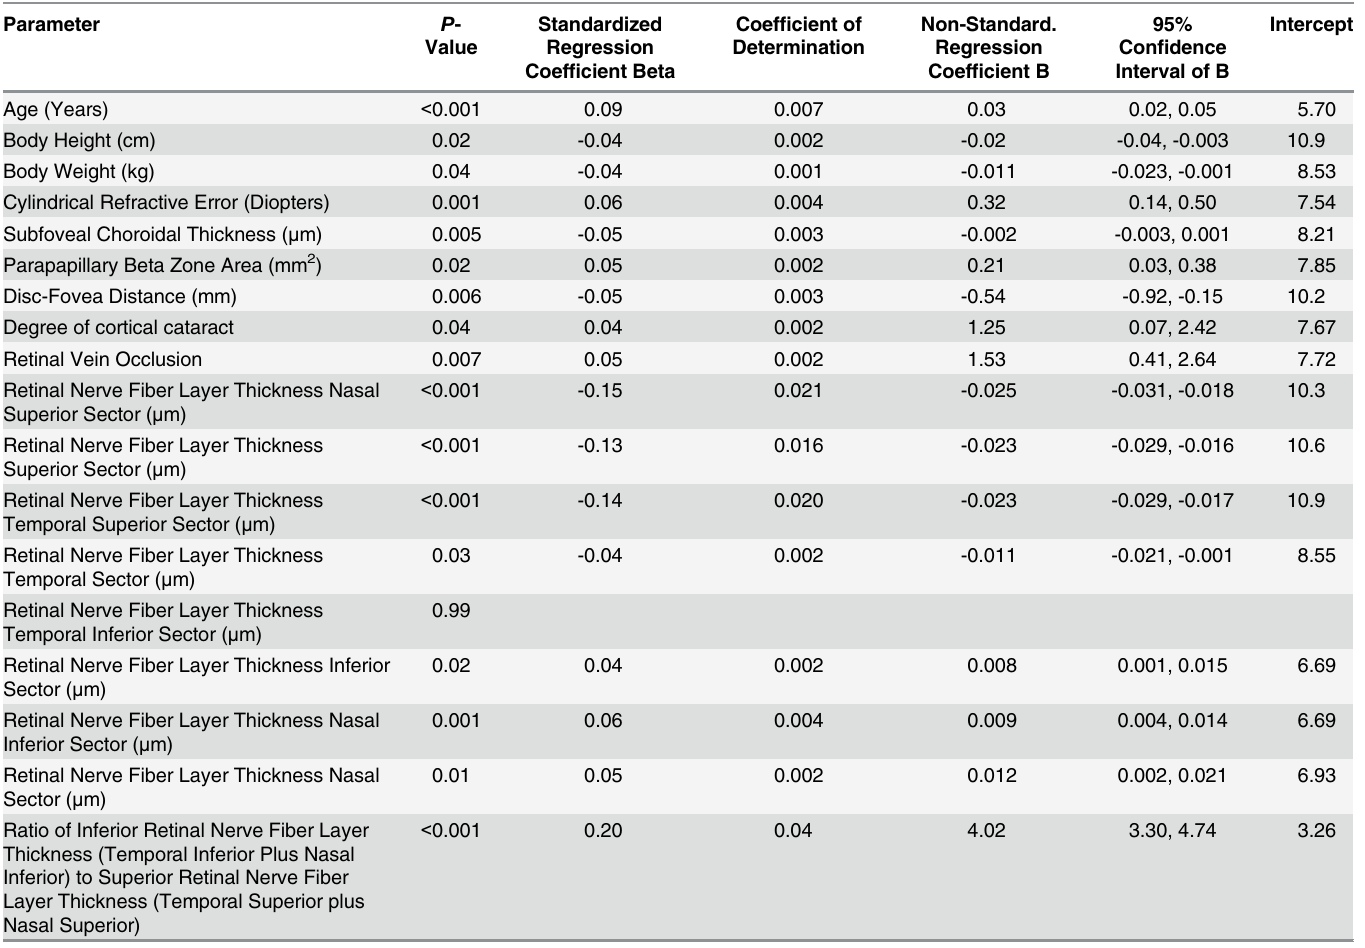
Table 1. Associations (Univariate Analysis) between the Disc-Fovea-Angle and Ocular and Systemic Parameters in the Beijing Eye Study